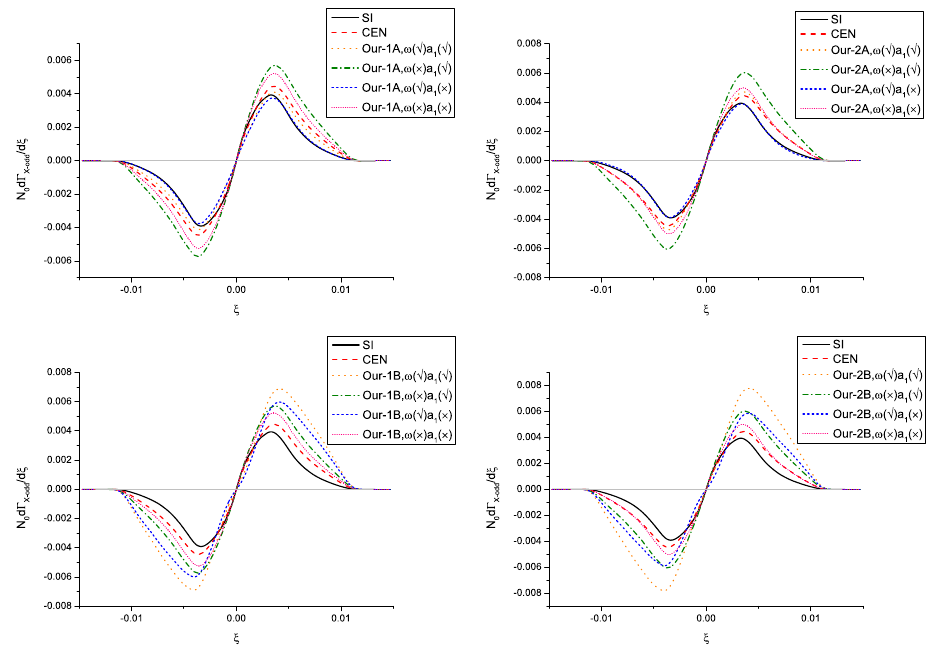
√ ) the ωρπ interactions